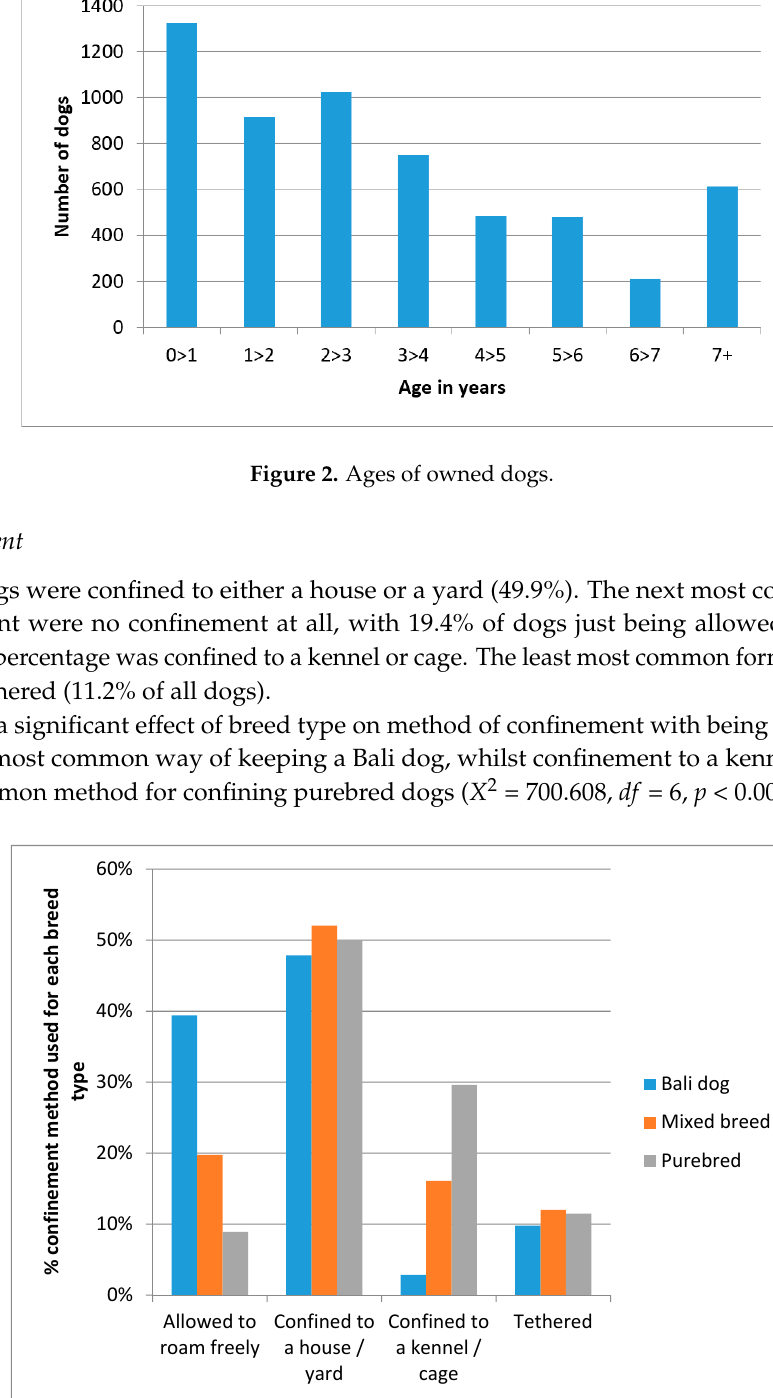
Figure 3. Confinement methods, separated by breed type.